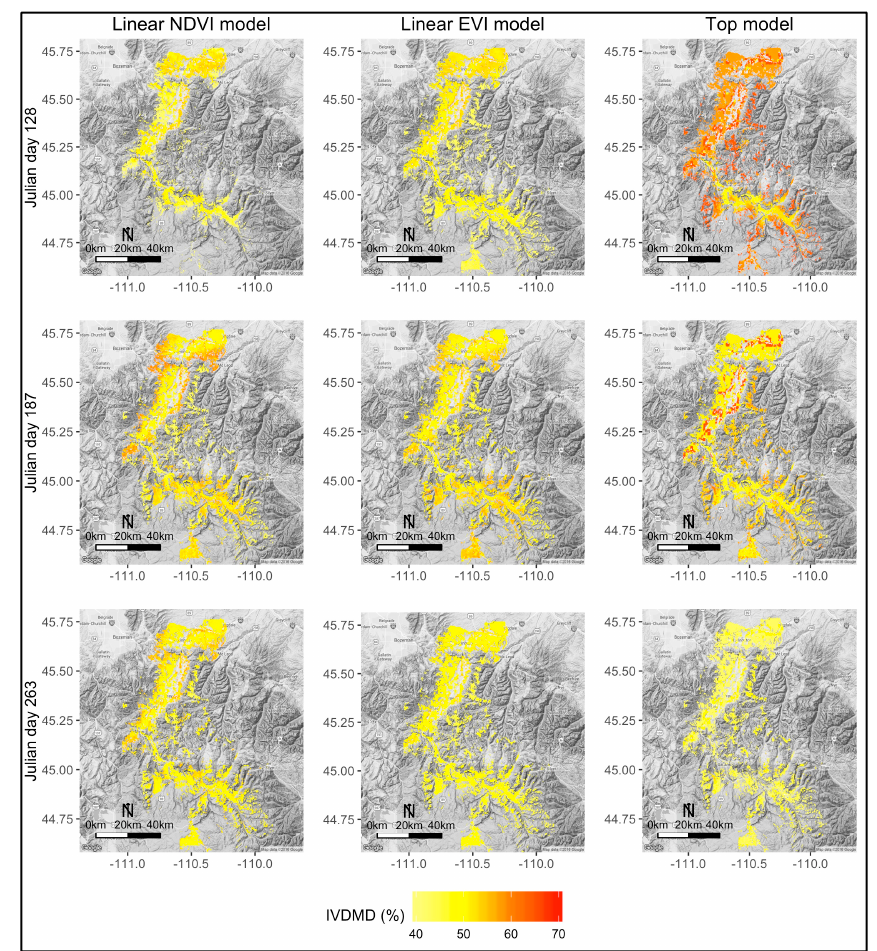
Figure 8. Maps of the IVDMD (%) of grasslands across the Upper Yellowstone River Basin on Julian days 128, 187, and 263 estimated from the linear NDVI, linear EVI, and the top models.